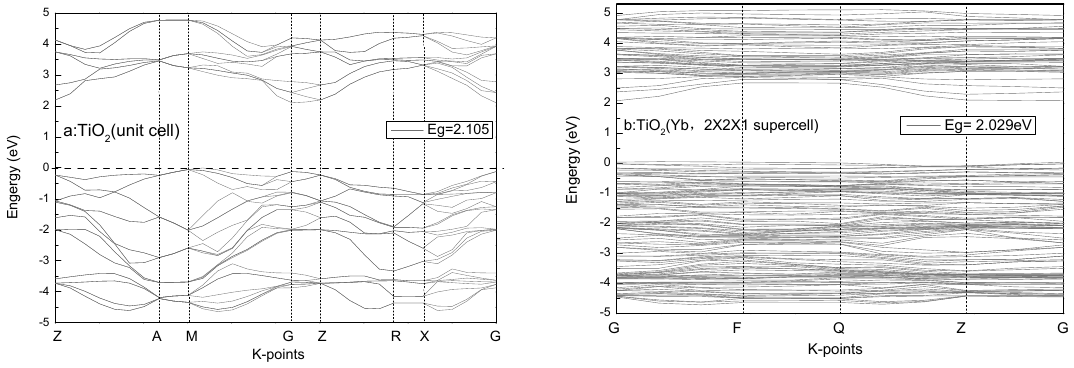
Figure 10. Band-gap structures of pure anatase TiO 2 and Yb-doped anatase TiO 2 (2 × 2 × 1 supercell). It is clear from the screening plots (Figure 11) that the introduced Yb 4f orbital mainly contributes to the top of the valence band, extending the impurities’ energy level into the forbidden band and producing a wider valence band in comparison with the pure cases. Meanwhile, both the top of the valence band and the bottom of the conduction band shift slightly with respect to the Fermi level, which results in the band gap narrowing and the consequent redshift response of the optical absorption edge.